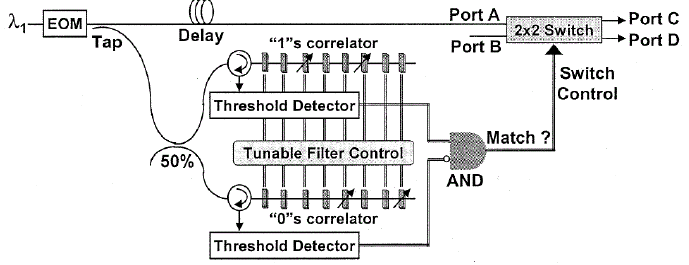
Figure 5. Optical header lookup as a pattern matching operation, combining 1 matches ( top ) and 0 matches ( bottom ).